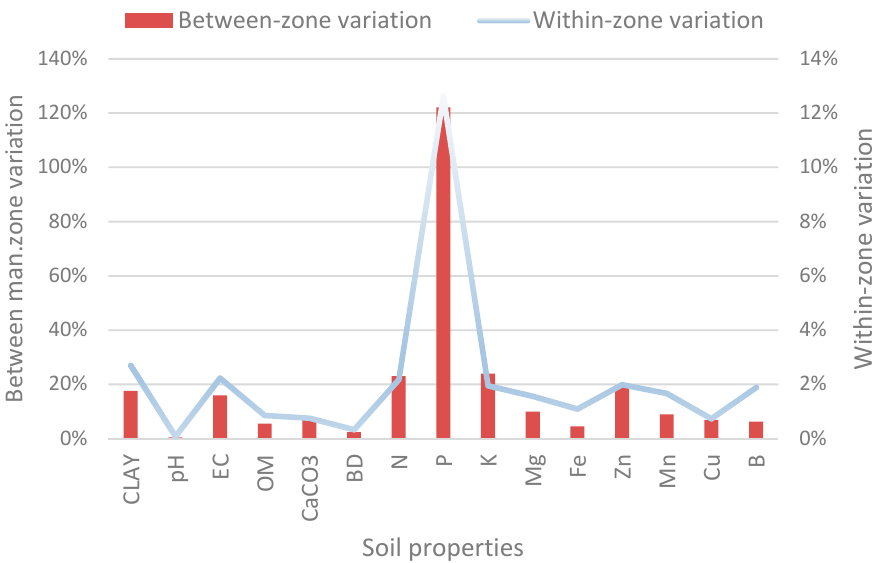
Figure 9. Plot of between- and within-zone variation for the analyzed soil properties.